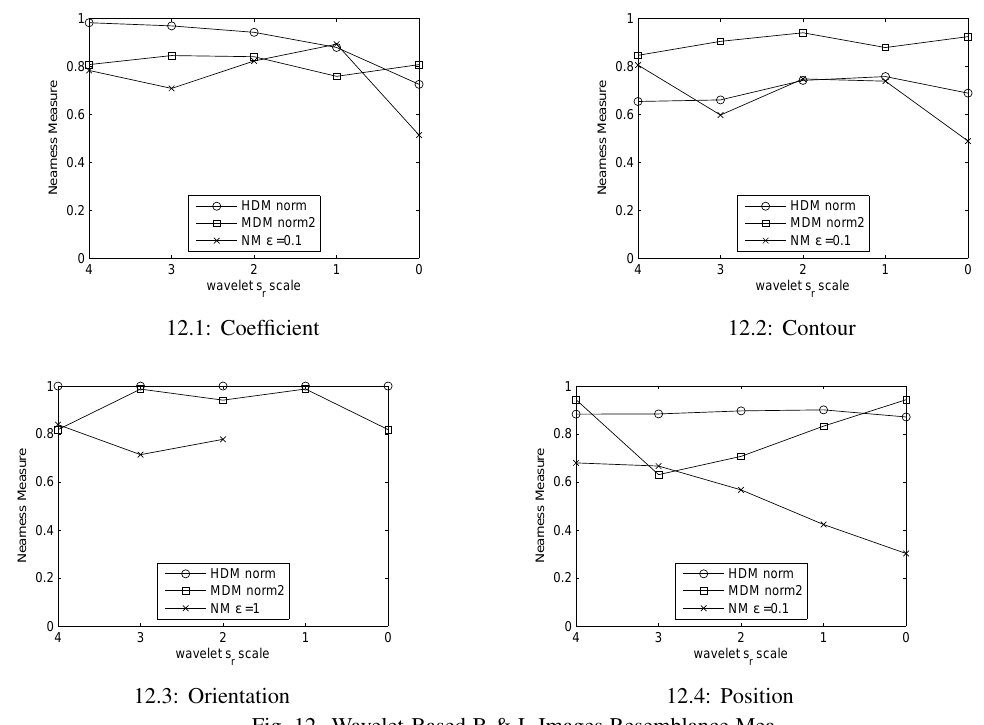
Fig. 12. Wavelet-Based B & L Images Resemblance Mea- surements